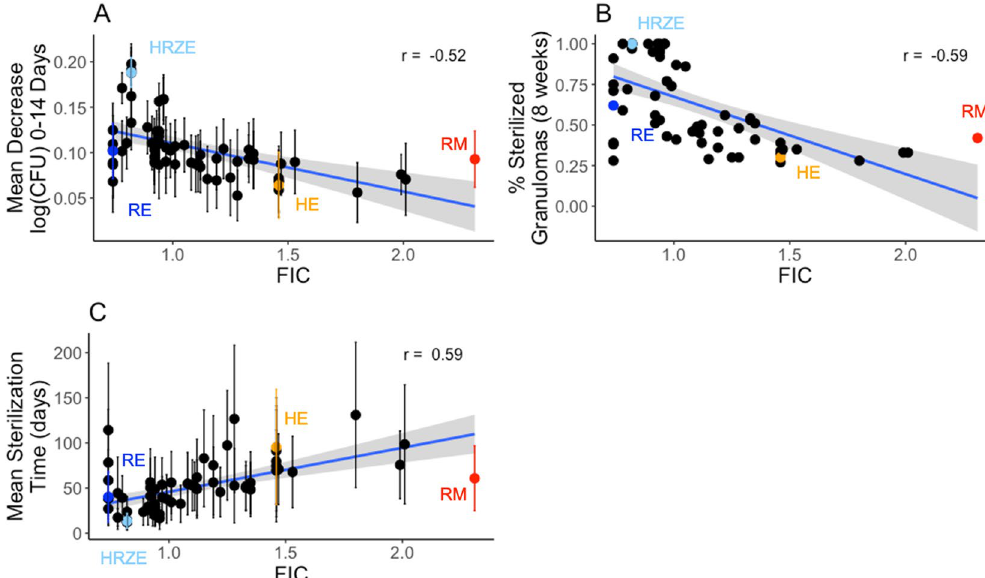
Figure 2. Regimen efficacy is correlated with FIC for 64 simulated drug regimens. Mean decrease in log CFU (0–14 days) averaged over 100 granulomas simulated for each drug regimen ( A ) and percentage of sterilized (negative) granulomas after 8 weeks of treatment ( B ) are negatively correlated with FIC values, with correlation coefficients of − 0.52 and − 0.59, respectively. Mean sterilization time for each regimen over 100 granulomas ( C ) is positively correlated with FIC with a correlation coefficient of 0.59. Each point represents the regimen outcome measurement for a given regimen and error bars indicate ± standard deviation from the sample of 100 granulomas simulated. The 64 drug regimens simulated are listed in Supplementary Table 1. The colored points correspond to the regimens HRZE (light blue), RE (dark blue), RM (red) and HE (orange) for emphasis. Plots were made using the ggplot2 package in R 39